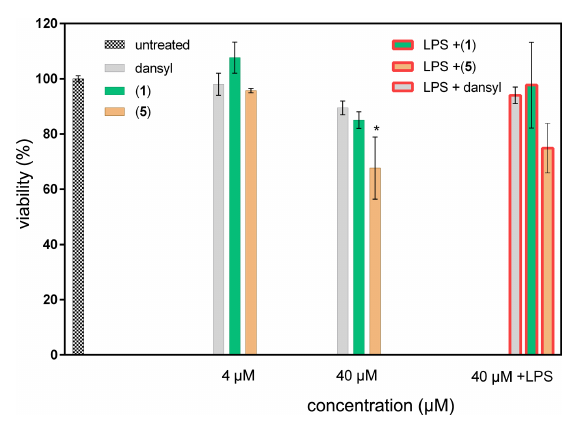
Figure 7: Viability of rat peritoneal cells treated with archangelolide ( 1 ), dansylarchangelolide 5 and dansyl amide itself. Compounds were applied at 4 µM and 40 µM concentrations and cells were cultured for 24 h. WST-1 assay was used for viability evaluation. The results are expressed as percentage of untreated control ± SEM of n = 6–8 values from two independent experiments. Statistical significance: * P < 0.05, the results of compound 5 are statistically different from those of untreated